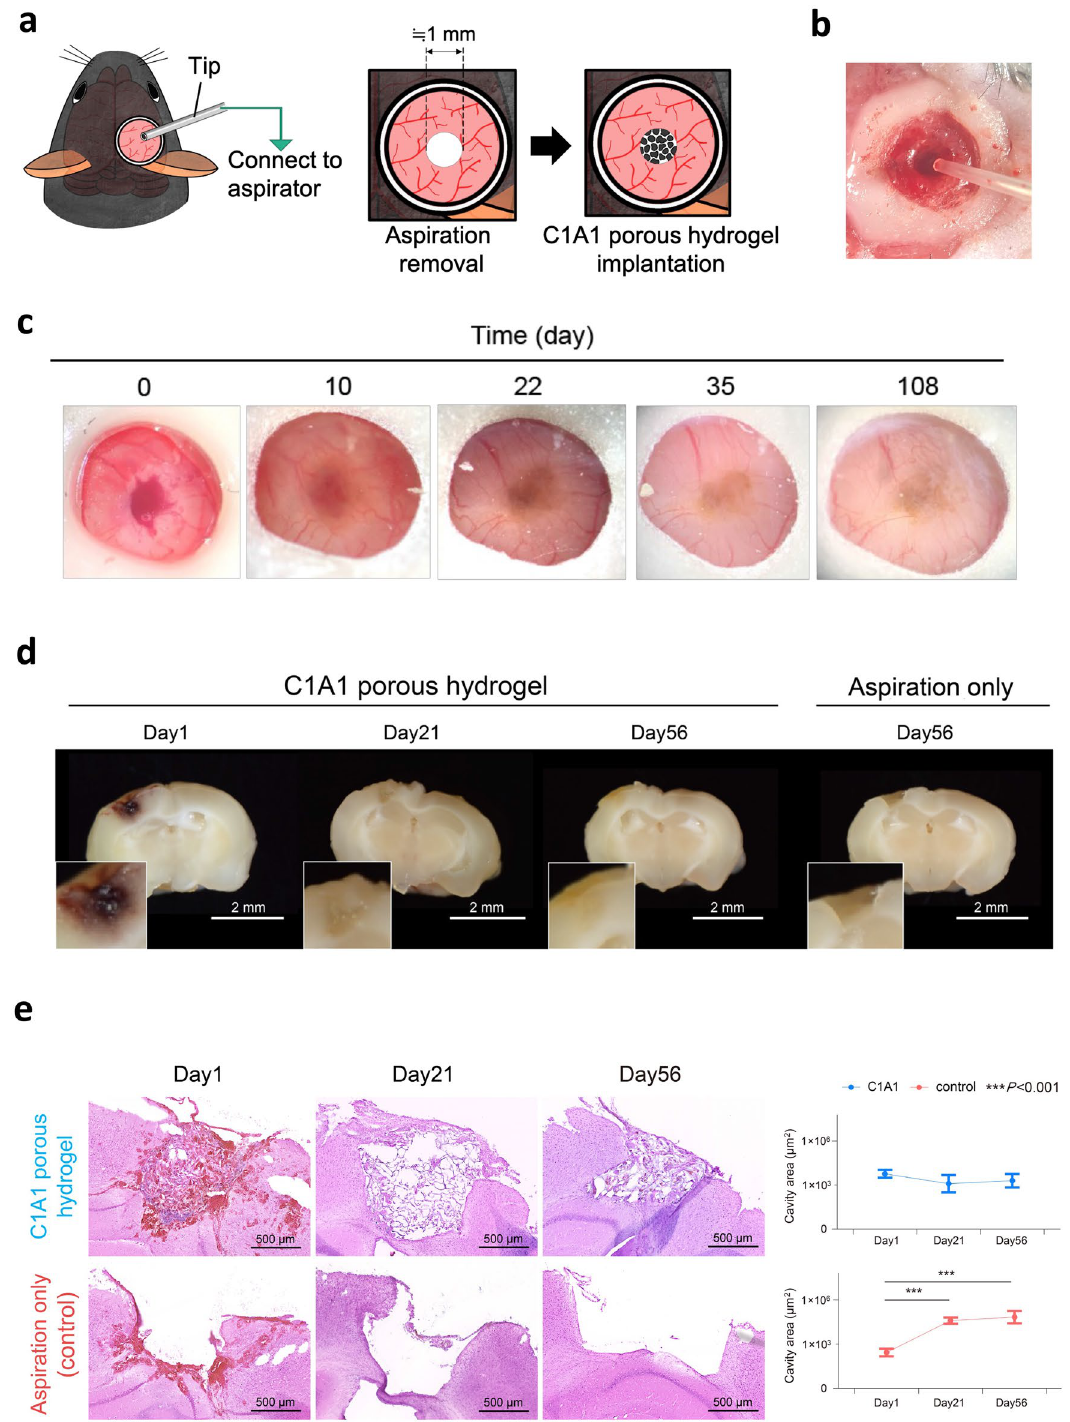
Figure 2. Establishment of a traumatic brain injury model and implantation of a C1A1 porous hydrogel into the mouse brain. ( a ) Illustration of the traumatic brain injury model in mice. The mouse brain was aspirated off as a cylinder shape, 1 mm in diameter and 1 mm in depth (left and middle), and a C1A1 porous hydrogel was implanted into the defect (right). Schematic figure was prepared by Procreate (version: 5X. https:// apps. apple. com/ jp/ app/ procr eate/ id425 073498). ( b ) Stereoscopic image of a brain defect. ( c ) Stereomicroscopic analysis of the implanted C1A1 hydrogel in the brain defect through a cranial window on days 0, 10, 22, 35, and 108. ( d ) Macroscopic analysis of the coronal section of the implanted C1A1 porous hydrogel in the brain defect on days 1, 21, and 56. A brain defect without implantation is shown (right). Bars indicate 2 mm for the lower magnification in the photograph. White boxes indicate higher magnification images of the implanted gels. ( e ) Histological analysis of brain defects by H&E staining with (upper panels) or without (lower panels) implantation of the C1A1 porous hydrogel on days 1, 21, and 56 (upper panels). The volume of the defect was determined as a hypothetical cylinder. The section with the largest defect area in the coronal section was selected, and the area of the defect drawn from the cortical surface of the telencephalon to the hippocampus was measured with Fiji. The volume of the virtual cylinder was calculated by multiplying the measured area by the diameter of the defect. Each area was graphed as the mean ± SEM. *** P < 0.001. n = 5,